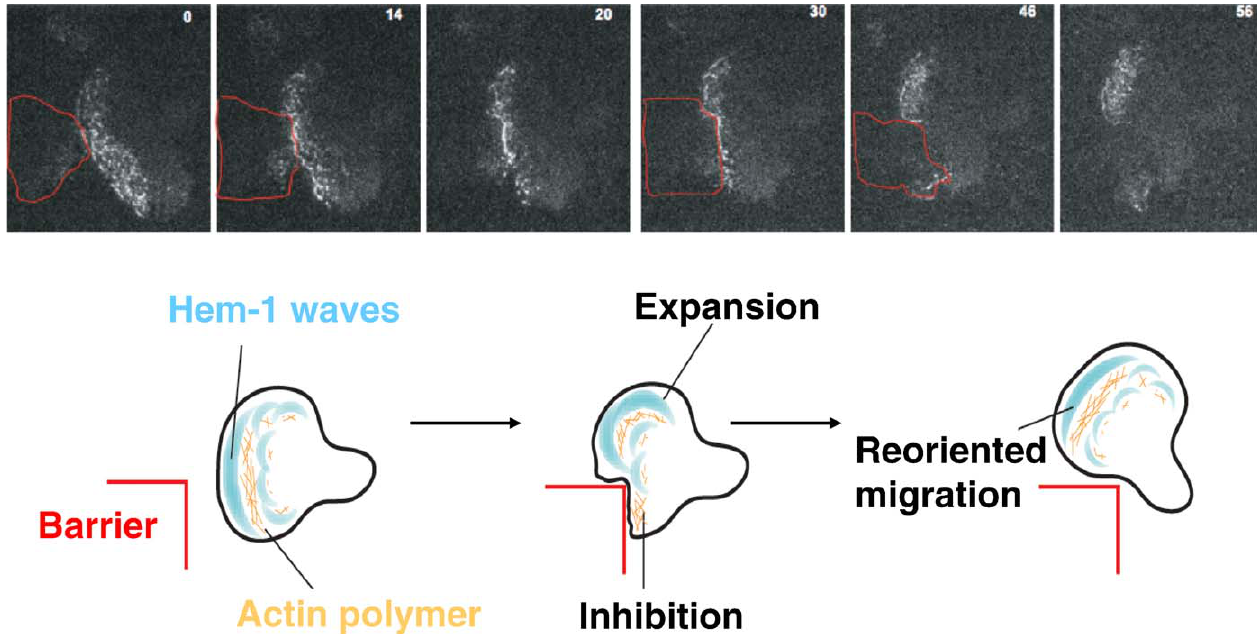
Figure 5. Hem-1 Waves Extinguish at Mechanical Barriers Hem-1 waves that collide with boundary (cell outlined in red) are extinguished, whereas those that do not continue to propagate (Video S18). The bottom schematic depicts our hypothesis for barrier avoidance. Hem-1 waves normally propagate just ahead of the actin inhibitory field. Stalling of waves by external barriers prevents Hem-1 from escaping removal by actin polymer-dependent inhibitory process, causing these waves to be extinguished. Waves in other regions of the cell continue to expand, enabling the cell to flow around barriers.